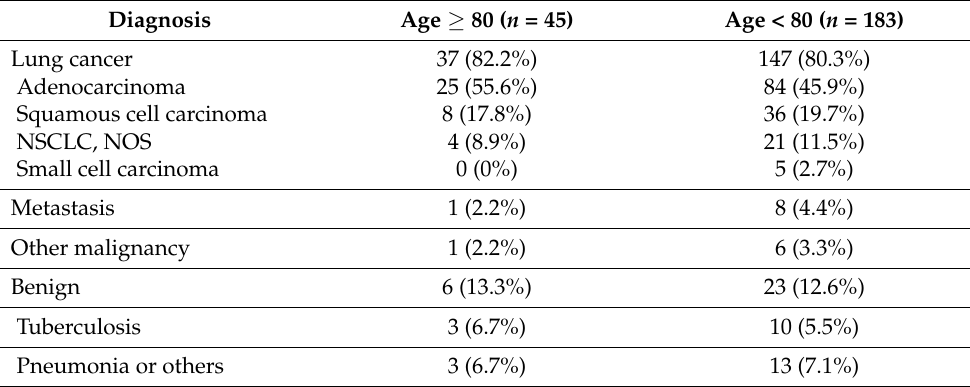
Table 3. Final Diagnosis of Study